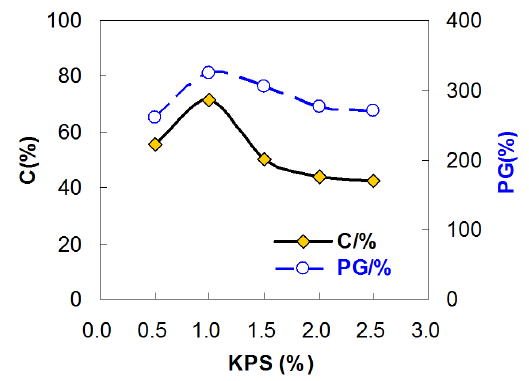
Figure 3. The effect of proportions of raw materials on C% and PG% (Cond.: w(BA) / w(MMA) = 1: 1, KPS: 1.50 wt.%, Temp: 85°C , Time: 8 hours).